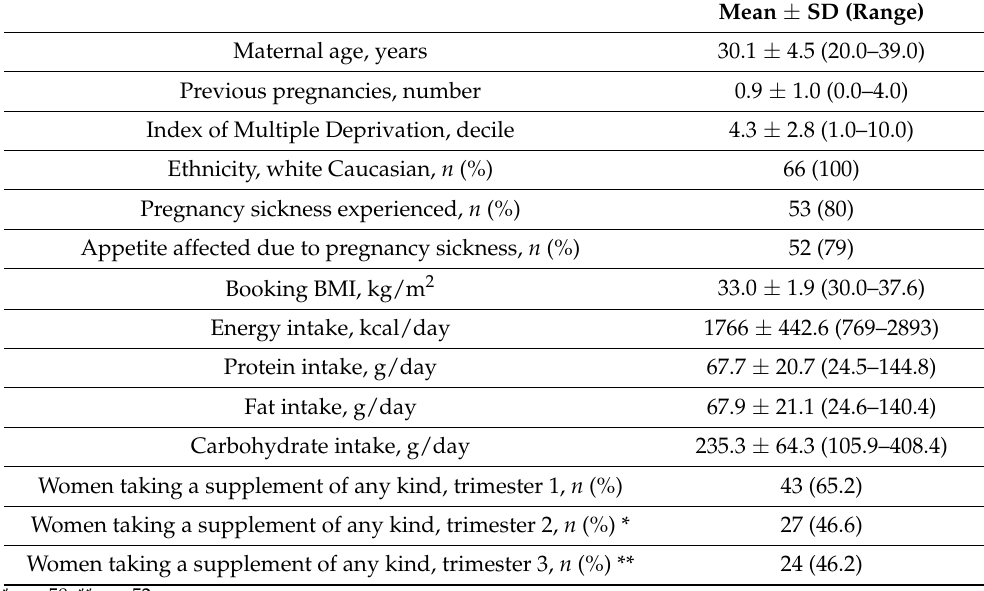
Table 1. Maternal descriptive data, n = 66.